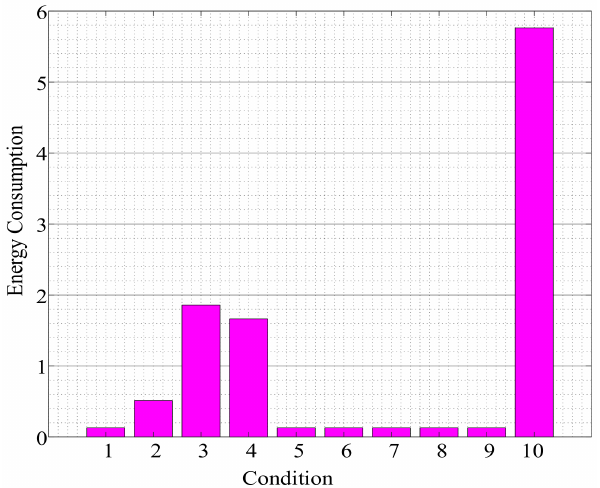
Figure 6. Energy for third line condition.